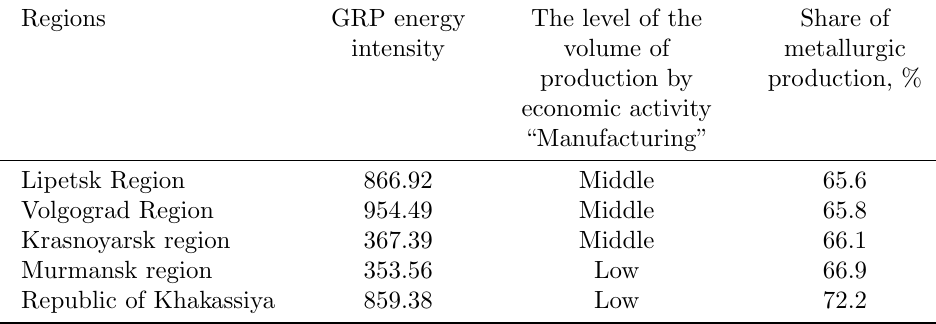
Table 3: GRP energy intensity for regions with a high share of metallurgic production in the volume of shipped production in the economic activity of